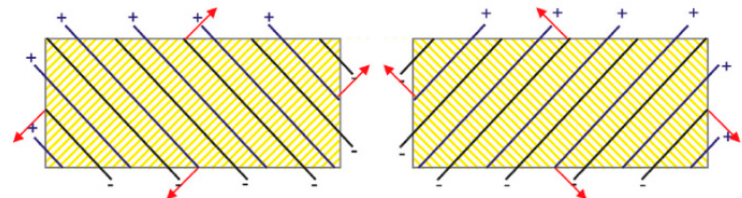
Figure 3. The two piezoelectric fiber patch (PFP) layers that overlie one another in a shear horizontal PFP (SHPFP) shown side-by-side. The red arrows indicate the resulting forces at the fiber ends of each individual layer (reprinted from [10] with permission from Elsevier).